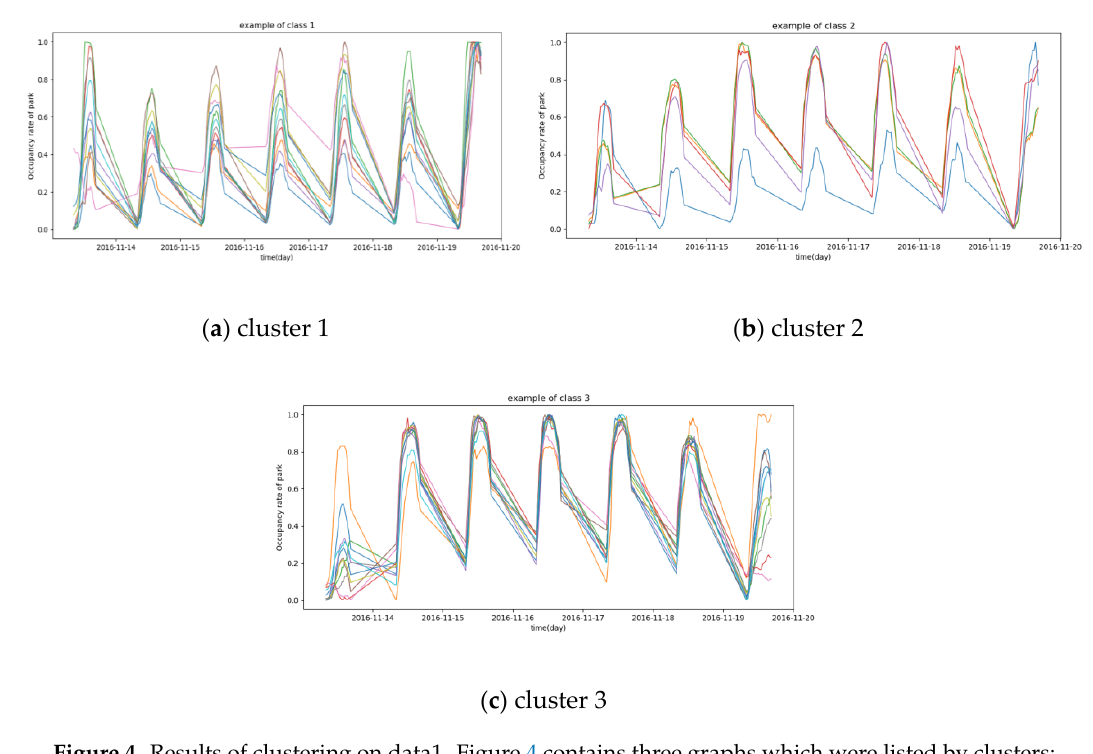
Figure 4. Results of clustering on data1. Figure 4 contains three graphs which were listed by clusters: ( a ) cluster 1, ( b ) cluster 2, ( c ) cluster 3.